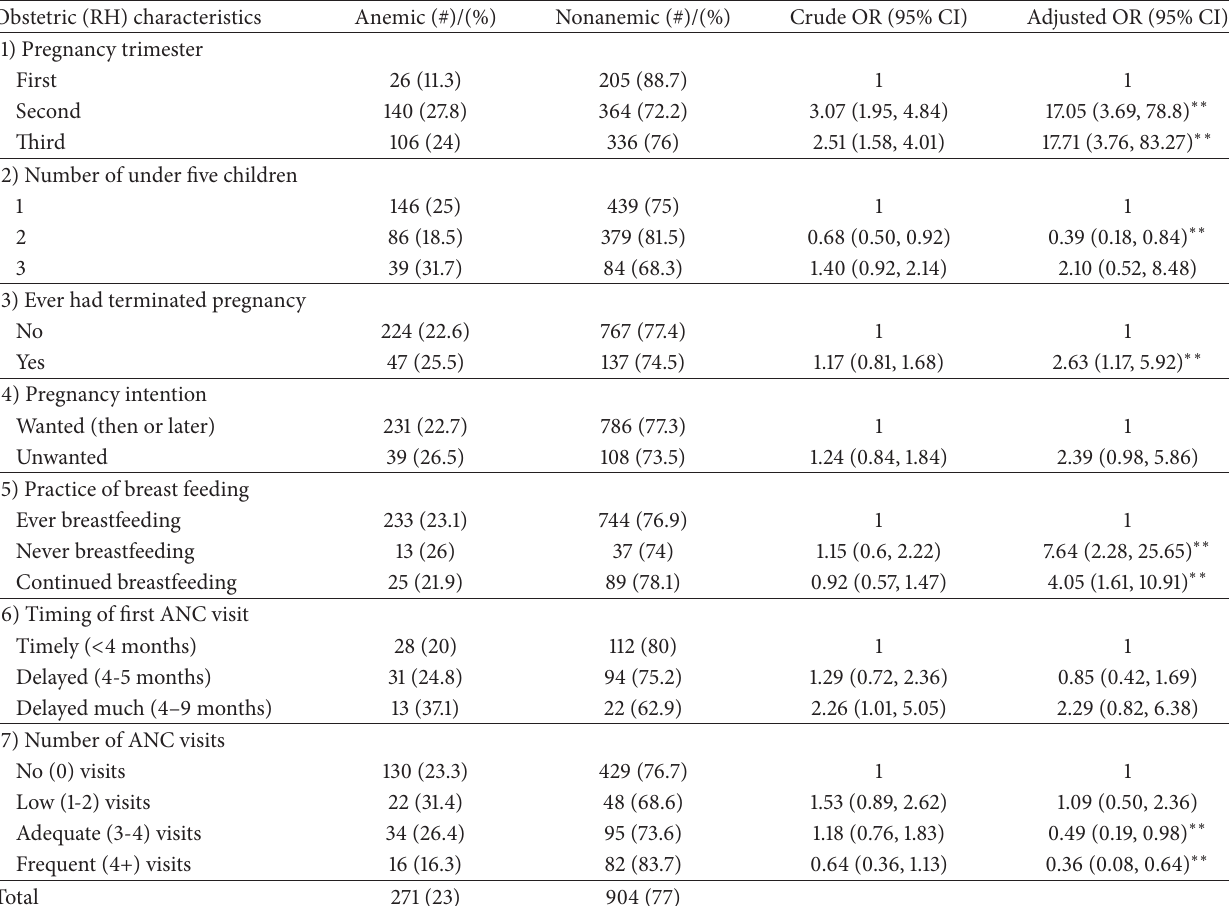
Table 3: Selected obstetric characteristics of pregnant mothers and their association with anemia during pregnancy in Ethiopia, EDHS 2011. Obstetric (RH)